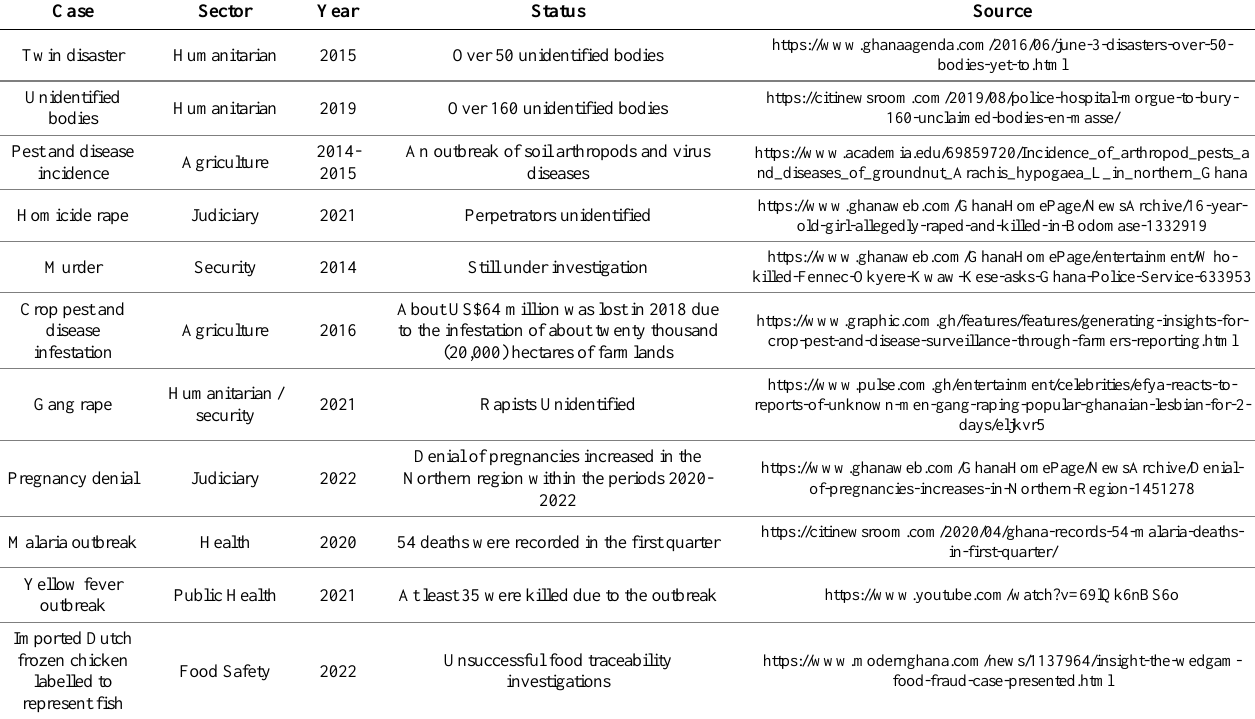
Table 2. Real Cases of Underutilization of DNA Technology in